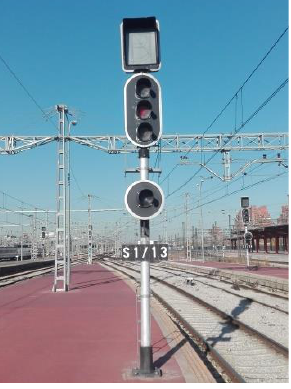
Figure 2. A light signal in a main station.